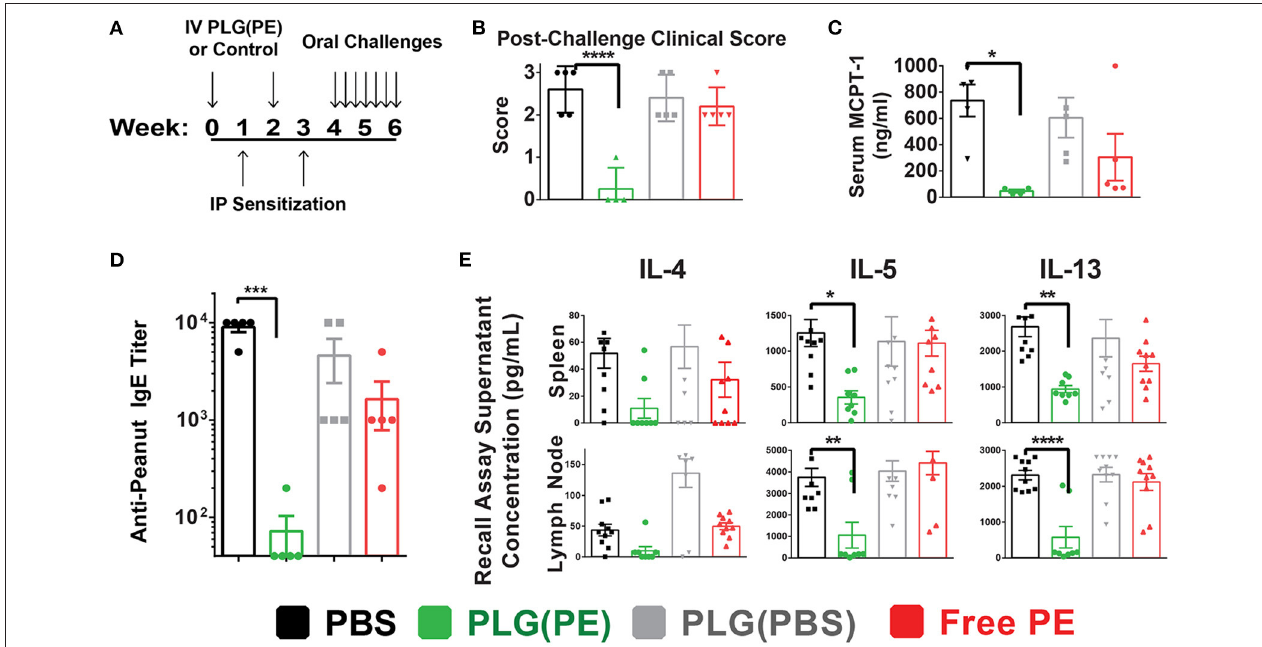
FIGURE 4 | PLG(PE) provides prophylactic protection from peanut allergy. C3H/HeJ mice were sensitized by i.p. injection of alum and peanut extract on Day 7 and 21 after receiving treatment or control on days 0 and 14. Seven intragastric challenges took place over days 28 through 42. Data represent the response to the 7th intragastric challenge. Schematic of experimental timeline (A) . Clinical anaphylaxis score was characterized (B) and serum MCPT-1 levels determined by ELISA (C) . Serum peanut-specific IgE levels were characterized (D) and cytokine secretion in culture supernatants of recall assays were measured by Luminex multiplex (E) . n = 5 per group. Plots display mean measurement ± SEM. Statistical significance determined with 1-way ANOVA with Dunnett’s multiple comparisons test: * P < 0.05, ** P < 0.01, *** P < 0.005, **** P <